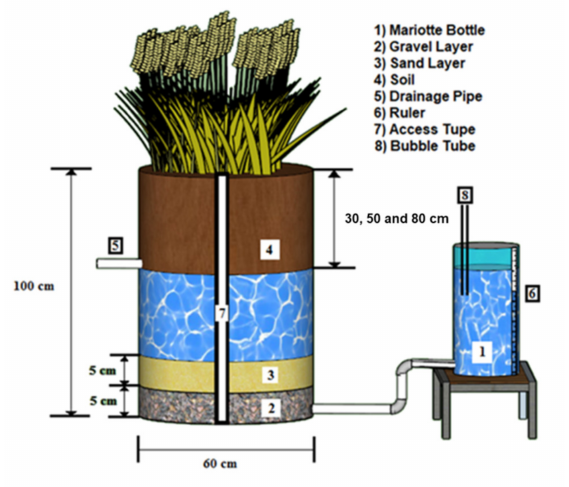
Figure 1. Schematic view of lysimeter and Mariotte bottle used in the